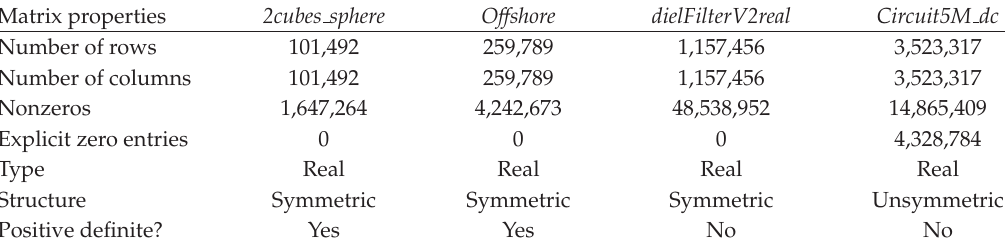
Figure 5: The Beowulf Linux cluster architecture. Table 1: Electromagnetic matrices properties.